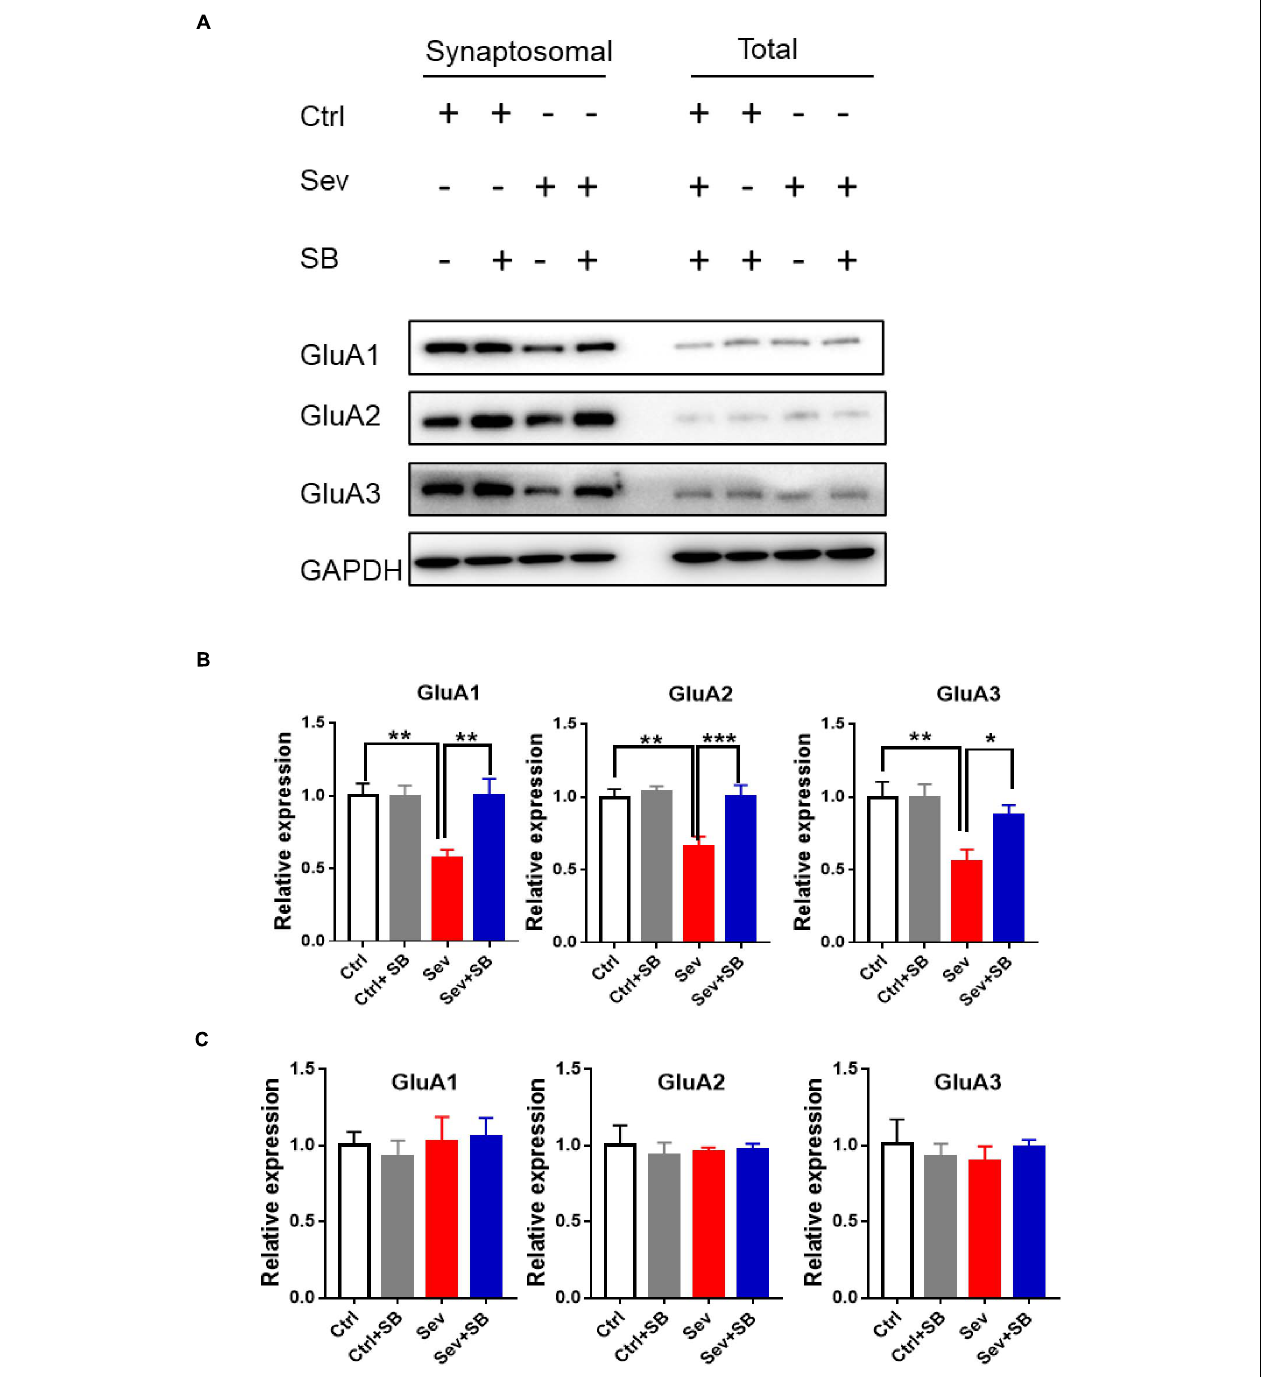
FIGURE 4 | Pre-treatment with TRPV1 antagonist SB 366791 reversed the decrease of the GluA1/2/3 AMPAR subunits caused by sevoflurane exposure. (A) Representative Western blots of GluA1/2/3 proteins in crude synaptosomal preparations and total cell lysate obtained from the hippocampal tissue of Ctrl, Ctrl + 500 µ g/kg SB 366791, Sev and Sev + 500 µ g/kg SB 366791 mice. (B) Quantitative analysis of the Western blots [crude synaptosomal, n = 8–10 mice per group, one way ANOVA, GluA1: F ( 3 , 32 ) = 6.5, p = 0.0015; GluA2: F ( 3 , 32 ) = 7.6, p = 0.0006; GluA3: F ( 3 , 32 ) = 6.0, p = 0.0023]. (C) : quantitative analysis of the Western blots (total protein, n = 8–10 mice per group). Data are presented as the mean ± SEM. ANOVA followed by Bonferroni post hoc test. * p < 0.05; ** p < 0.01; *** p < 0.001. Ctrl, control; Sev, sevoflurane; SB, SB 366791.